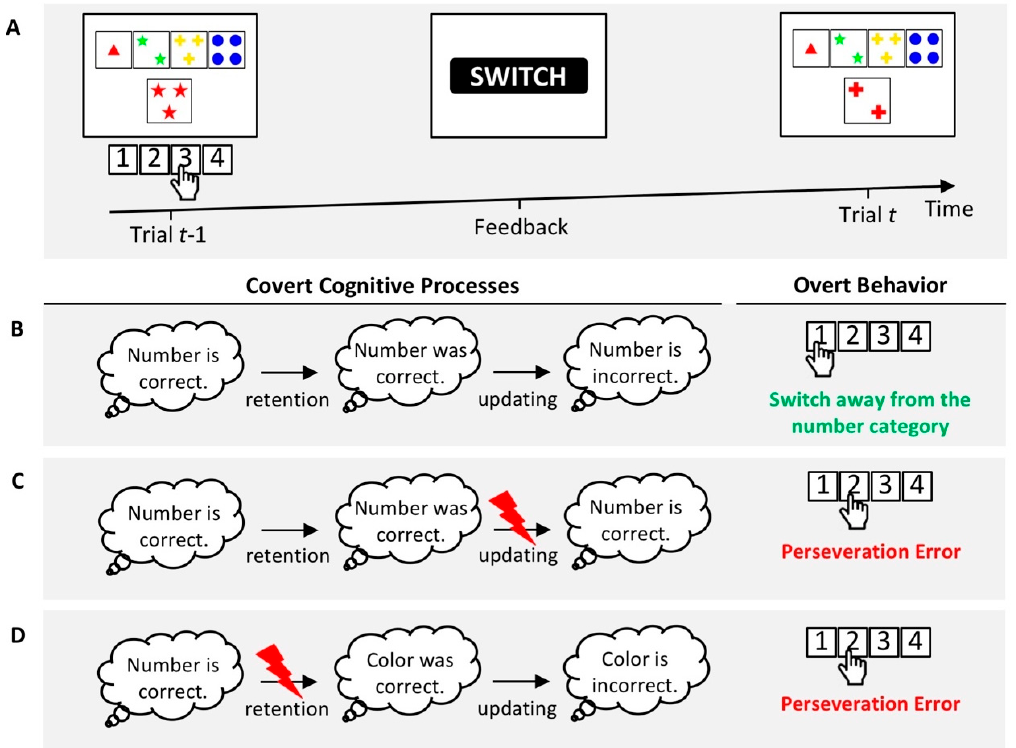
Figure 2. Increased perseveration error (PE) propensities may result from separable impairments of covert cognitive processes. ( A ) An exemplary sequence on a computerized WCST variant. On Trial t − 1, the execution of response 3 indicates the application of the number category. A subsequently presented negative feedback cue (i.e., “SWITCH”) indicates that the application of the number category was incorrect. Thus, a switch away from the number category is requested on Trial t . ( B ) A successful switch away from the number category on Trial t may rely on a number of covert cognitive